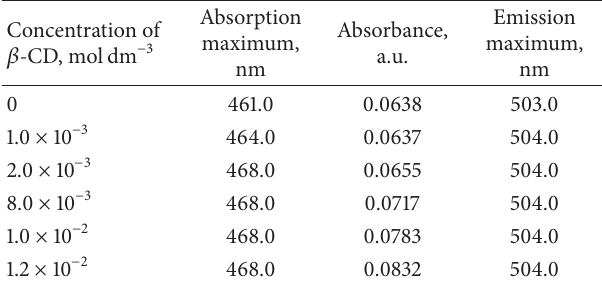
Table 1: Absorption and fluorescence spectral data of C334 with various amounts of 𝛽